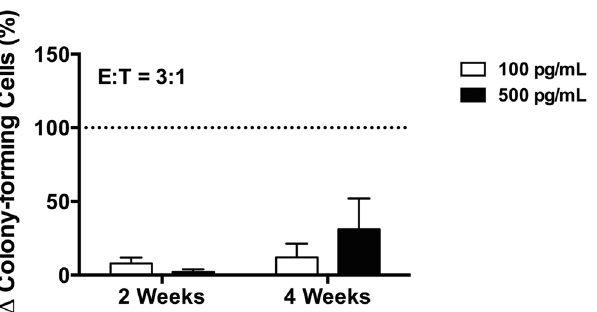
Fig 5. Effect of AMG 330 on colony-forming cells (CFC). AML cells were incubated without AMG 330 or in the presence of 100 pg/mL or 500 pg/mL of AMG 330 together with healthy donor T-cells (labeled with CellVue Burgundy dye) at an E:T cell ratio of 3:1. After 48 hours, CellVue Burgundy dye-negative primary AML cells were separated by FACS and subsequently cultured for up to 4 weeks. After 2 and 4 weeks, aliquots of cultures cells were subjected to CFC assays. 10 – 14 days later, CFU-GMs were quantified and plating efficiency determined. Data (CFU-GMs/10,000 plated cells) from aliquots incubated with AMG 330 and healthy donor T-cells are expressed relative to aliquots incubated without AMG 330 (with no-AMG 330 controls set at 100%). Depicted are data from 16 AML specimens that yielded CFU-GM growth without AMG